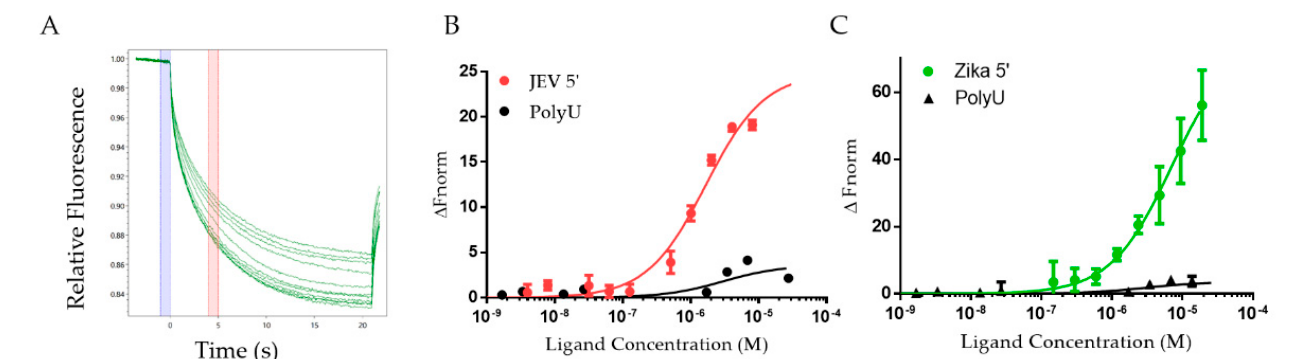
Figure 3. Interaction studies using microscale thermophoresis (MST). ( A ) Representative MST traces depicting the change in fluorescent migration of fluorescein-5-thiosemicarbazide (FITC)-JEV 5 (cid:48) TR due to the excitation with an infra-red laser. Each green trace correlates to a different concentration of DDX3X 132–607 . ( B ) Binding data for DDX3X 132–607 with JEV 5 (cid:48) TR ( n = 3). The red curve represents JEV 5 (cid:48) and has a dissociation constant of 1.66 ± 0.21 µ M (Std. error of regression = 1.25). The black trace represents that polyU (negative control) does not interact with DDX3X 132–607 . ( C ) Interaction between DDX3X 132–607 and ZIKV 5 (cid:48) TR ( n = 3) studied using MST. The green curve represents ZIKV 5 (cid:48) and has a dissociation constant of 7.05 ± 0.75 µ M (Std. error of regression = 1.22). PolyU binding data included for reference (black).